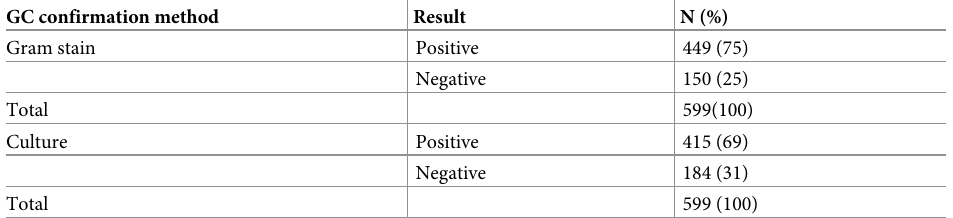
Table 2. Comparison of gram stains and culture methods for the detection of gonococcus isolates from urethral discharge specimens.